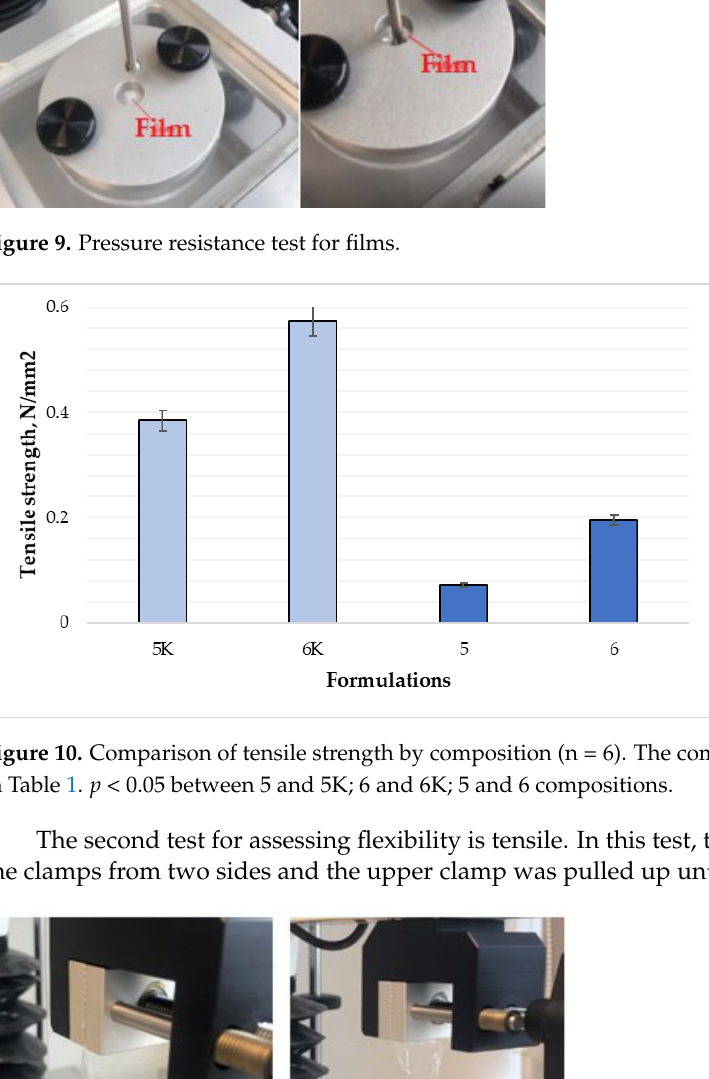
Figure 12. Comparison of tensile value of films by composition (n = 6). The composition values are given in Table 1. p < 0.05 between 5 and 5K; 6 and 6K; 5 and 6 compositions. The results of the films ’ flexibility showed that the resistance and tensile tests do not correlate and the effect of the essential oil the elasticity of the films could not be proven. Furthermore, due to the conflicting results of the two tests, it would not be correct to claim that the flexibility of composition 6 is better than composition 5. 3.6. Water Vapor Penetration Test Results The water vapor permeability test is an important indicator that shows how the film is able to retain moisture in the wound. During the test, samples were placed in an incu- bator and kept for 24 h. After 24 h, the samples were analyzed and weighed. The subjects were slightly pale after the test. This was most likely due to the ability of nitrocellulose to interact with water molecules and turn from colorless to white (Figure 13).